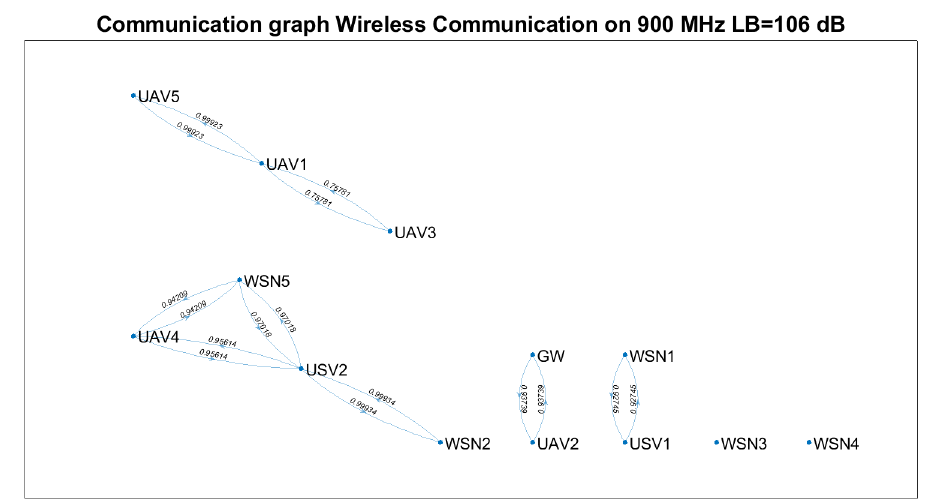
Figure 7. Communication graphs for the technical solutions in